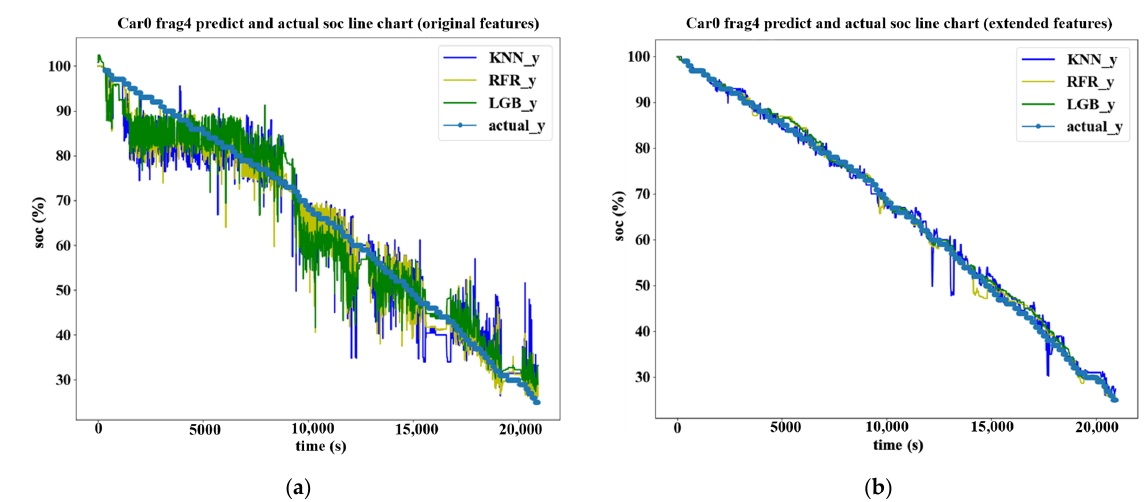
Table 3. Performance of three machine-learning models on the dataset. Algorithm